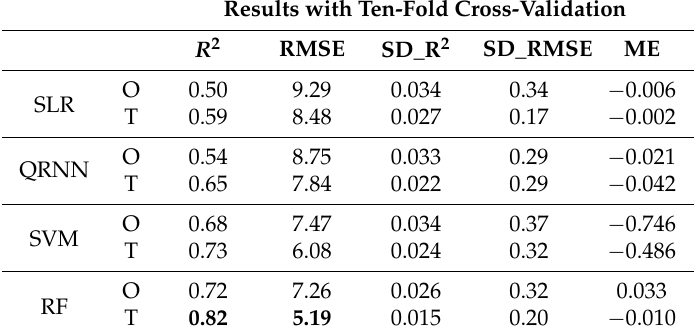
Table 2. Modeling comparison with different algorithm in 2009. The comparison was performed with original spectral indexes (O) and temporal trajectory (T), separately. SD stands for standard derivation. The best results were marked in bold. Results with Ten-Fold Cross-Validation R 2